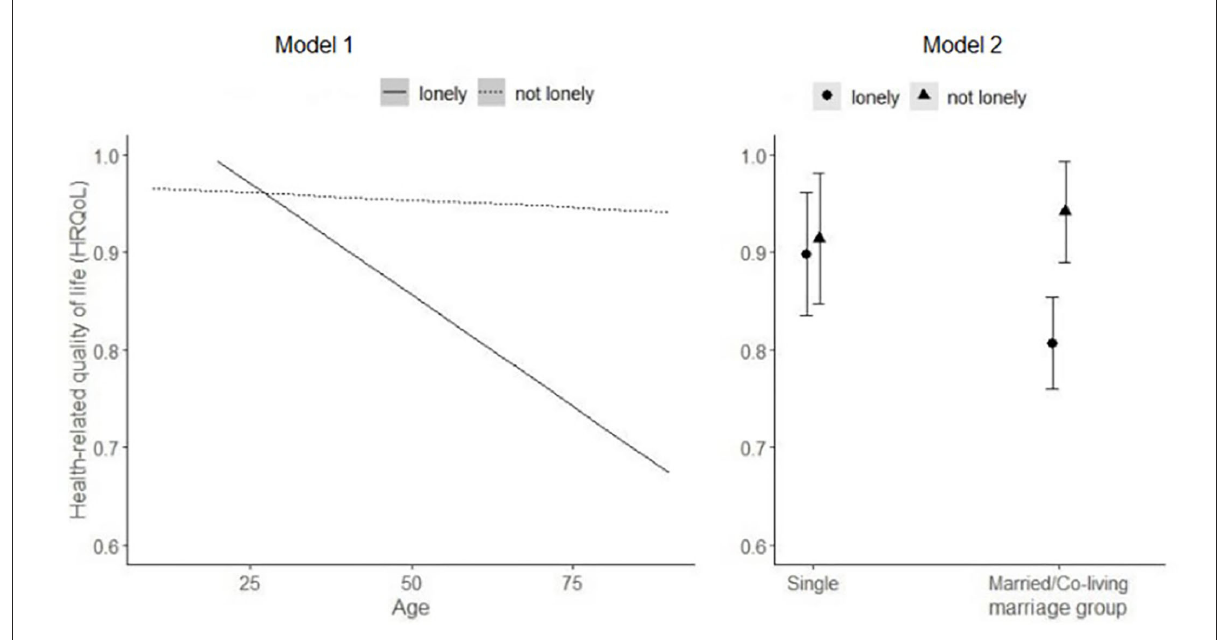
FIGURE2 Interaction impact of loneliness with age or marital status on HRQOL under